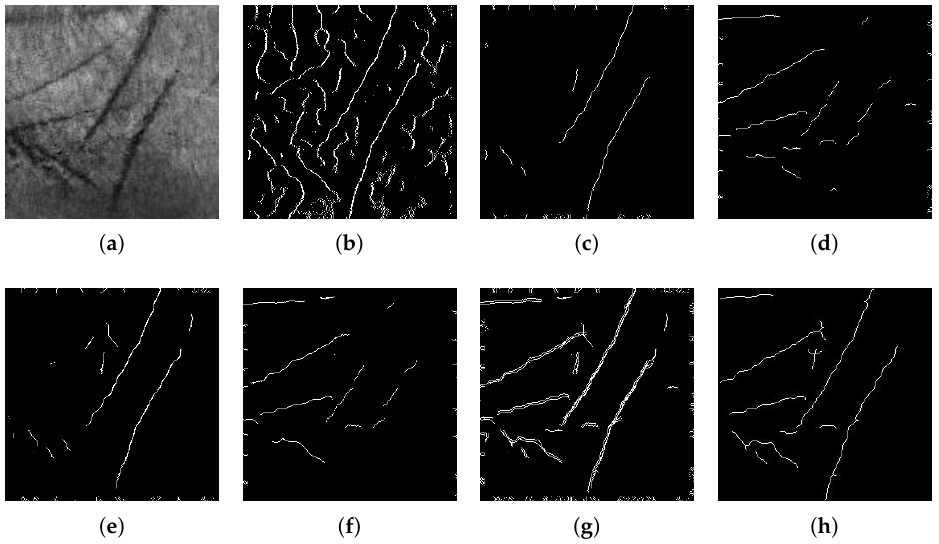
Figure 3. Palmprint feature extraction procedure step by step: ( a ) 2D grayscale image at 350 µ m; ( b ) image after detection of edges; ( c ) feature extraction along direction 0° ( d ) 90° ( e ) 180° ( f ) 270° ( g ); logical OR of images after feature extraction along four directions; ( h ) final 2D